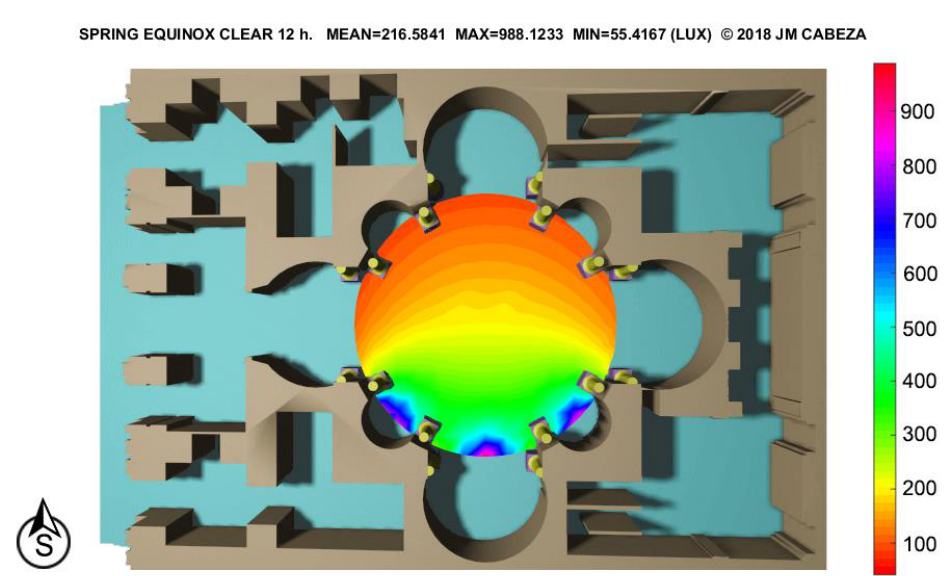
Figure 5. Typical sunny day at noon in Spring. All the values are in unit of lux. Some points may reach illuminances around 1000 lux. Source: Authors.